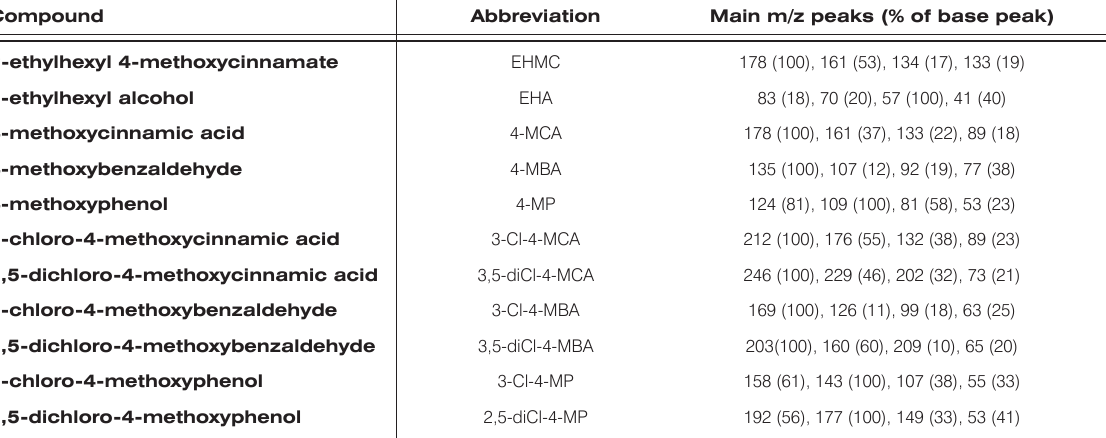
Table 2. Mass spectral data of non-chlorinated compounds detected in all reaction mixtures and chloroorganic products detected in the EHMC/H O /HCl/UV 2 2